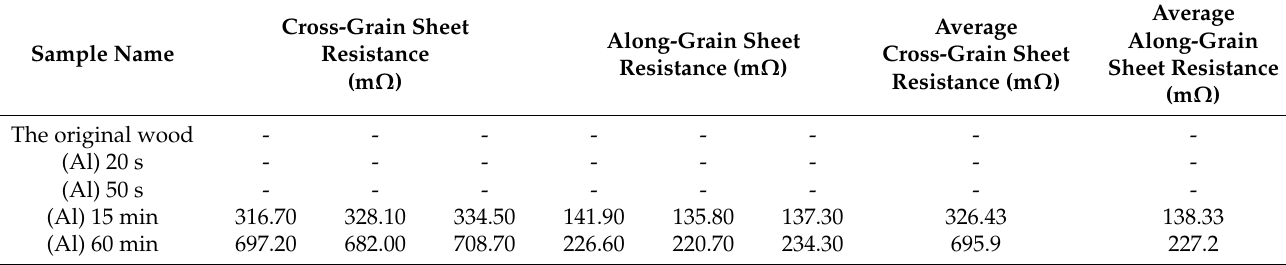
Table 1. Surface resistance value of nano-Al metallized